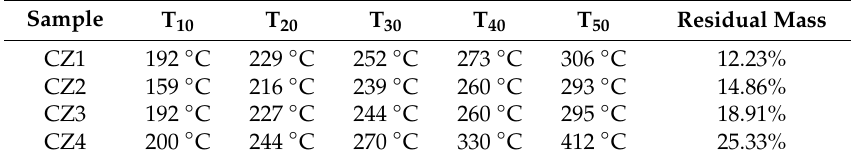
Table 3. Temperatures at which chitosan and CZ1–CZ4 films lost 10%, 20%, 30%, 40%, or 50% of initial mass.